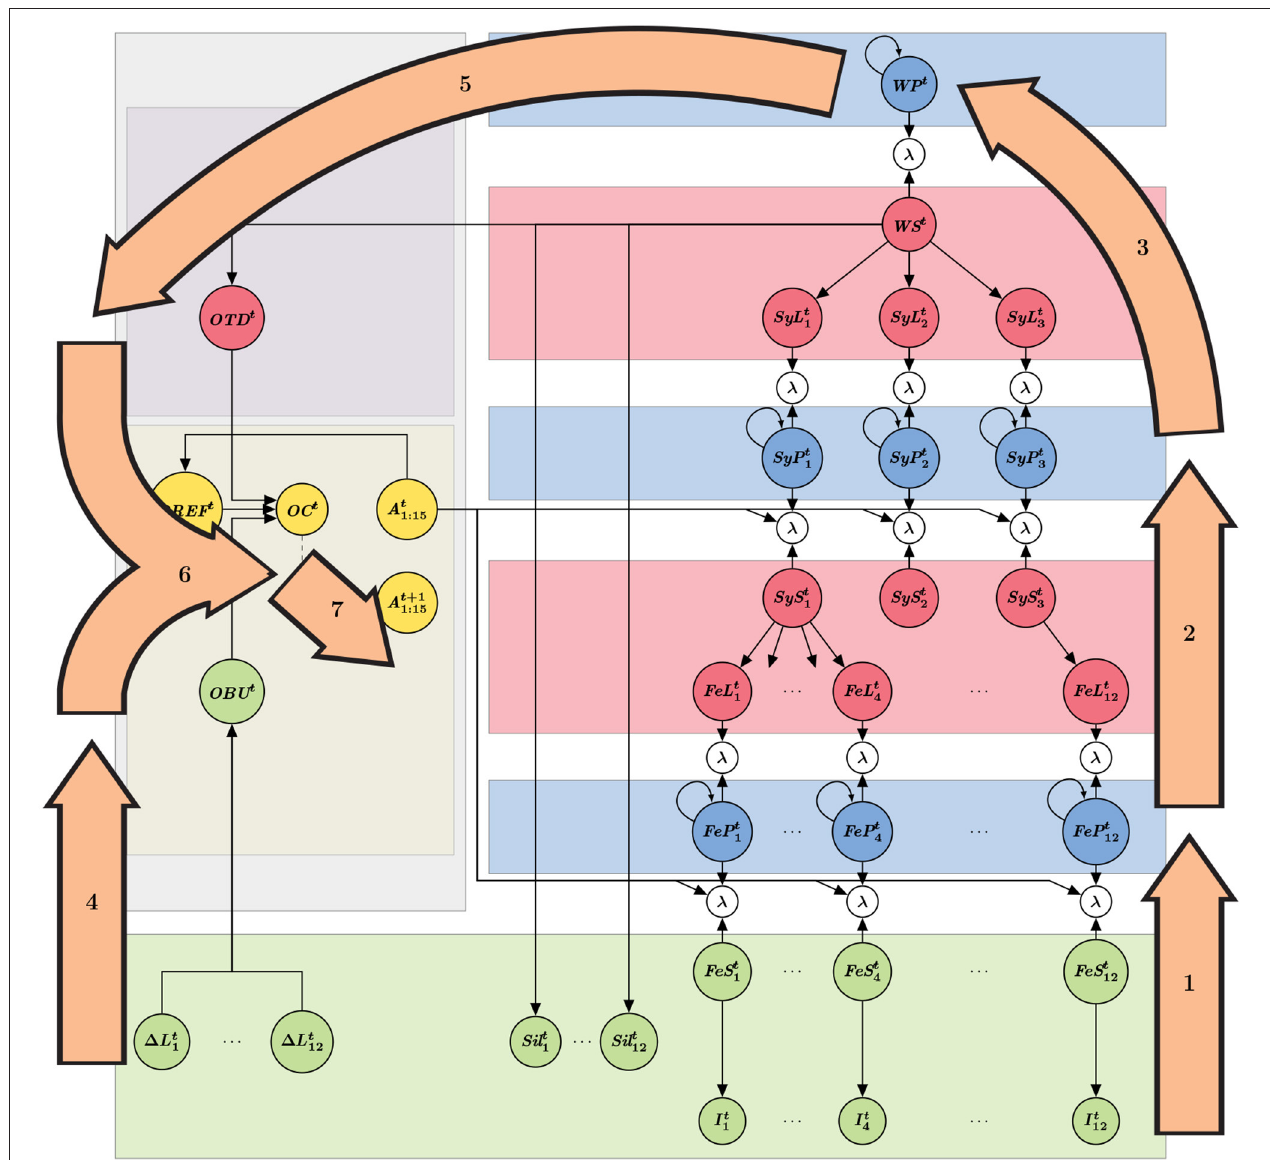
FIGURE 2 | Graphical representation of computation steps to perform word decoding and onset detection. Orange arrows indicate inference steps, labeled in the order they are performed, and roughly superposed to the relevant portions of the model for each step (see Figure 1 ). Step 1 is feature decoding, step 2 is syllable decoding, step 3 is word decoding; these steps are performed in a purely feedforward manner in the decoding module (i.e., no lexical feedback to bias syllable or feature decoding). In the blue nodes, incoming input information is combined with information of the previous time-step. Step 4 is bottom-up onset detection from the input, step 5 is lexical, top-down onset prediction, step 6 is the combination of the results of steps 4 and 5 (applying either the AND or the OR operator). Finally, step 7 is a decision process on the combined onset probability; when an onset is detected, the states of decoding gates (open or closed) are changed. Notice that it is precisely at step 7 that the implementation shifts toward the next time step, thus breaking the probabilistic dependency cycle to avoid complex computational loops.